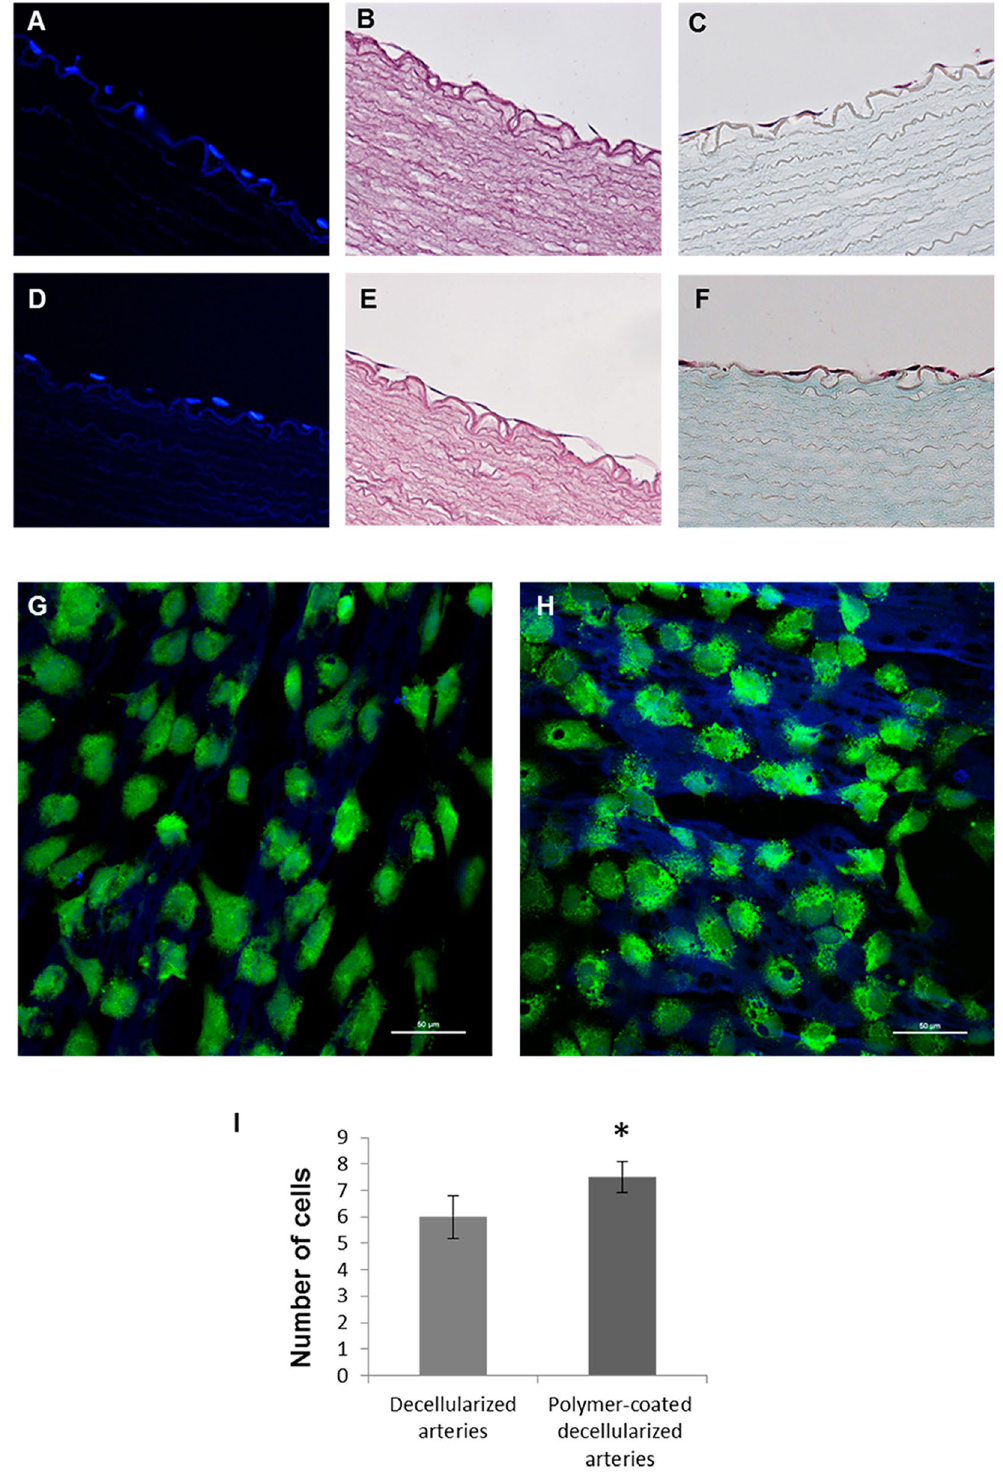
Figure 5. Porcine recellularized arteries after 5 days in culture. Representative fluorescent microscope images of the nuclei stained with DAPI (blue): ( A ) decellularized arteries and ( D ) polymer-coated decellularized arteries (magnification; x40). H&E staining showing endothelial cells: ( B ) decellularized arteries and ( E ) polymer- coated decellularized arteries. Masson's Trichrome staining: ( C ) decellularized arteries and ( F ) polymer-coated decellularized arteries (magnification; x40). Confocal microscope images of live cell labeled with cell tracker green: ( G ) decellularized arteries and ( H ) polymer-coated decellularized arteries. Scale bar = 50 μ m (magnification; x40). ( I ) Cell number determination by ImageJ Software on four representative histological staining images of decellularized arteries and polymer-coated decellularized arteries at 40x magnification from independent experiments ( * p <